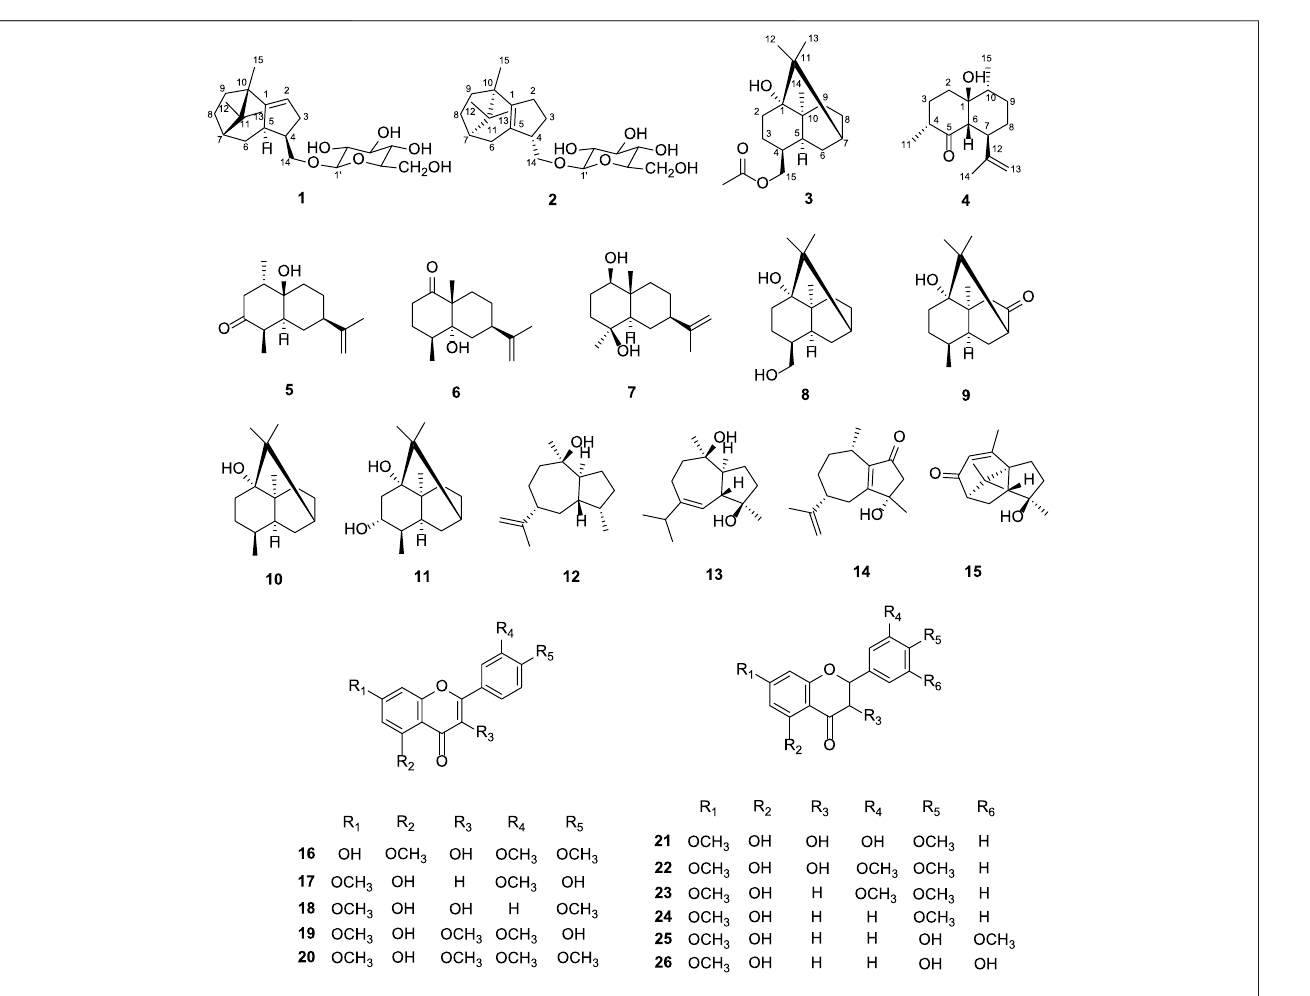
FIGURE 4 | Chemical structures of compounds 1 - 26